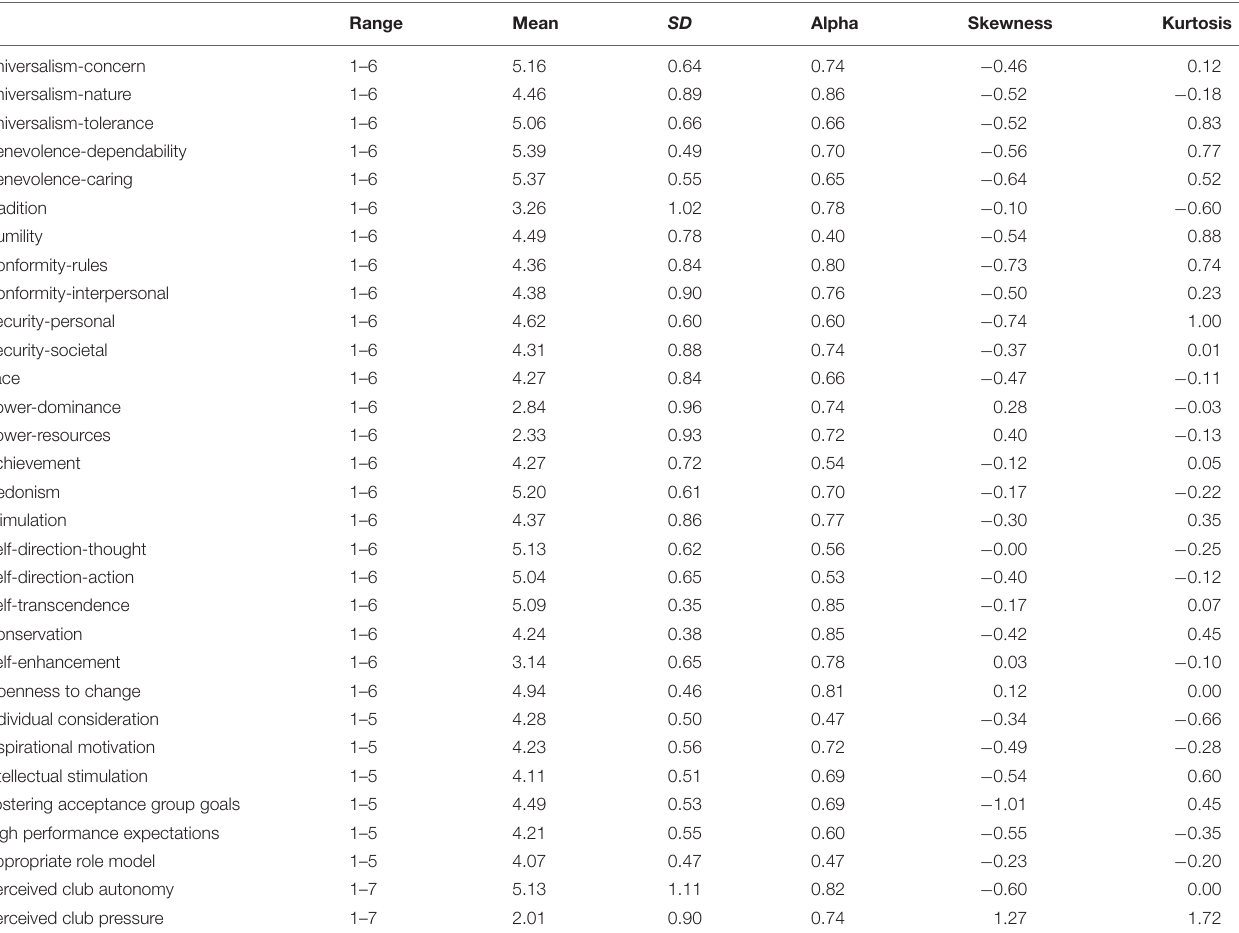
TABLE 3 | Descriptive statistics and reliability of all the study variables (19 basic values, 4 value dimensions, coach behaviors, perceived club autonomy and perceived club pressure) ( N = 266